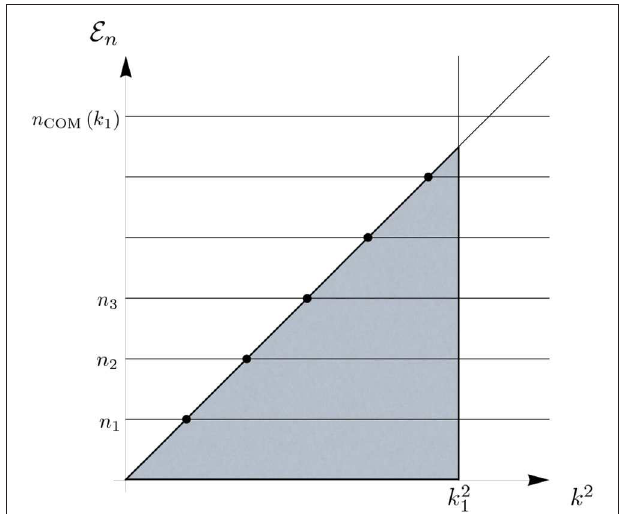
2 constructed via a − ¯ g k 2 . The black 7→ g ] ( k 1 ) are associated to the ¯